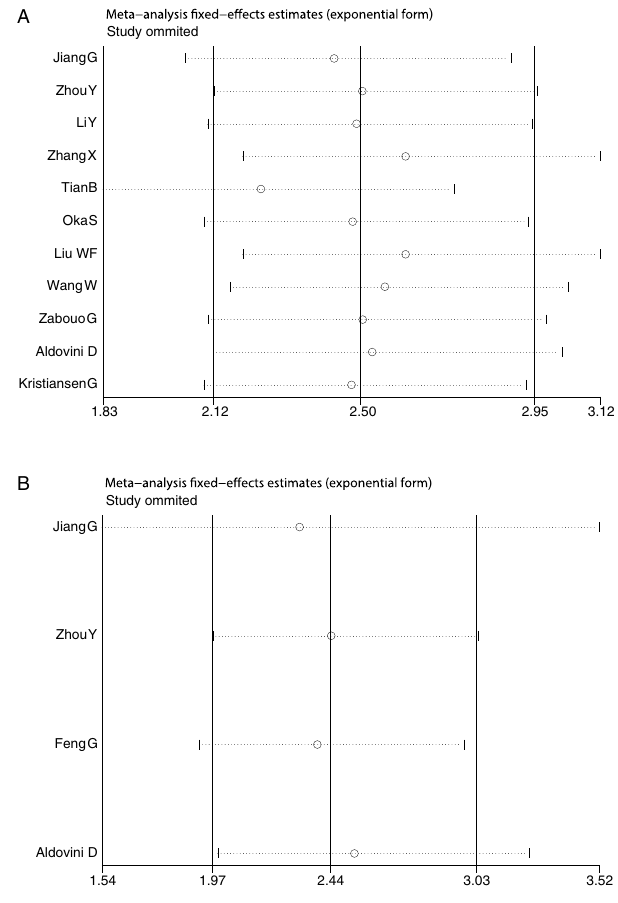
Figure 5. Sensitivity analysis of the meta-analysis. ( A ) Overall survival. ( B ) Time to progression